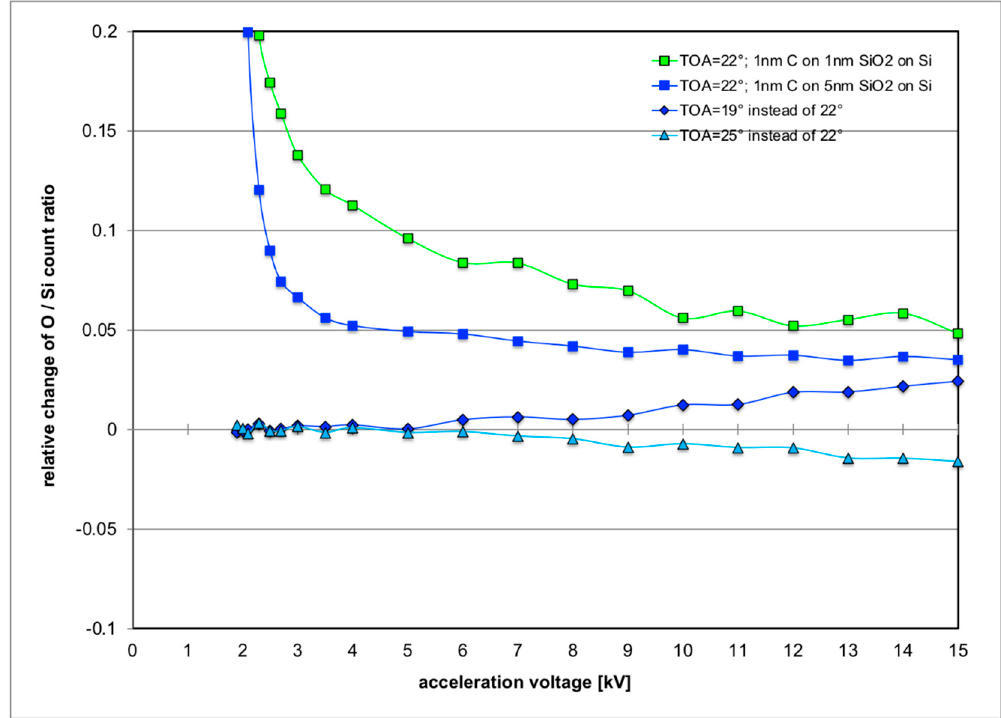
Figure 5. MC simulation of predicted relative change of O/Si X-ray count ratio vs acceleration voltage for SEM-EDXS with standard Si detector when either the take-off angle (TOA) is varied by ±3° or a 1 nm thin carbon contamination of the sample surface is taken into account.